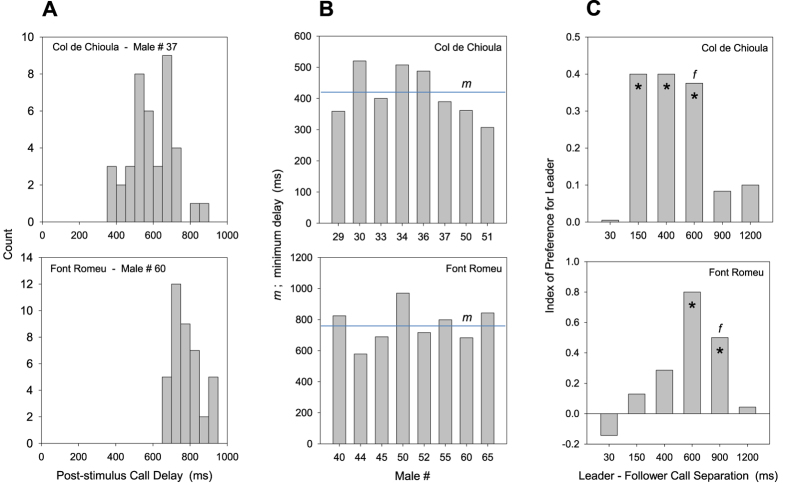
Timing parameters in male chorusing and female preference.(A) Call delay histograms of representative males from 2 populations (Col de Chioula, Font Romeu; Fig. 4A). The numbers of calls produced during 50-ms bins beginning at the onset of a synthetic call stimulus broadcast at random intervals are shown. The post-stimulus delay of the earliest of the male’s 40 calls following inhibition is equivalent to m in Fig. 1. (B) Minimum post-stimulus call delay, m, for each of 8 males tested via playback in the 2 populations. A male’s m is determined as the average of his 3 shortest delays. The population’s m is the average of the individual male values. (C) Index of preference by females in the 2 populations for the leading of 2 synthetic call stimuli broadcast in close succession. For a given population, the maximum leader-follower call separation at which the index remained ≥50% of the highest index value observed across all call separations was designated as f; in all but one population this highest index value was significant (Ho: index = 0.0; 1-tailed sign test, α = 0.05; each female that preferred the leader in >50% of trials was labelled ‘+’ and labelled ‘−’ if < 50%; the sign test was performed on the labels of all females tested for responses to a given call separation). *Index of preference >0.0.